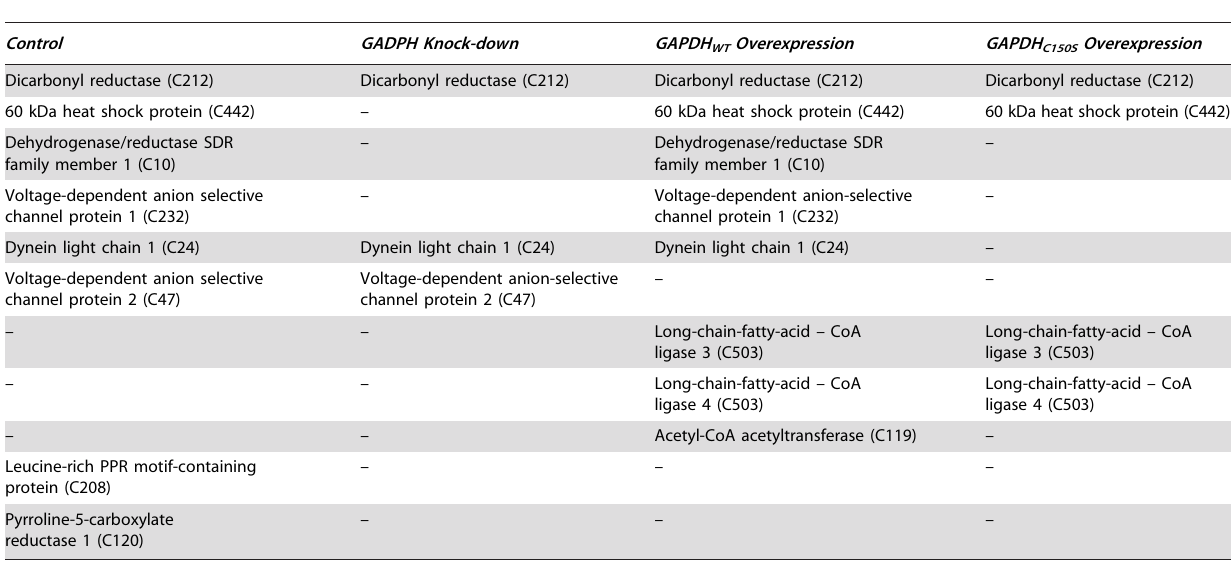
Table 2. SNO proteins from HepG2 cells as identified via SNO-RAC proteomic analysis.